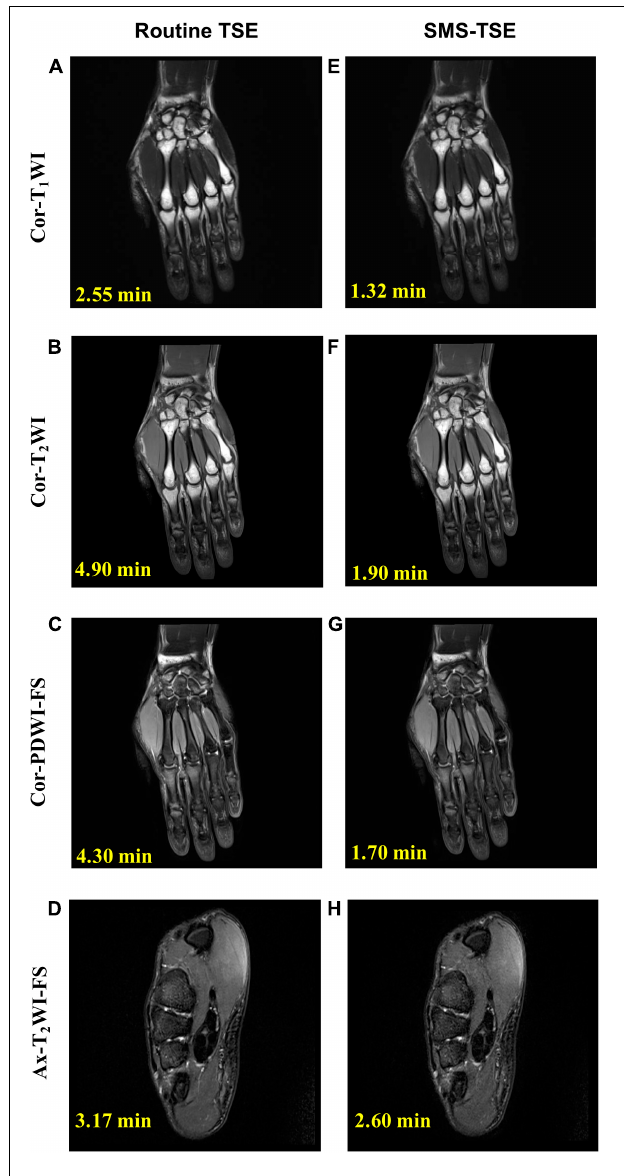
FIGURE 1 | Comparison of high-resolution turbo spin-echo (TSE) sequence and simultaneous multi-slice-TSE sequence in the wrist joint imaging. The median nerve is thickened and swollen and shows hyperintensity on axial-T2-weighted imaging-fat saturation imaging (arrow), and the final diagnosis is carpal tunnel syndrome. All the images scored 5 in the image quality evaluation. For routine TSE, the SNR for Cor-T1WI (A) , Cor-T2WI (B) , Cor-PDWI-FS (C) , and Ax-T2WI-FS (D) were 228.46, 108.76, 279.91, and 123.75; and the CNR for each was 192.21, 313.92, 72.77, and 71.55. For the SMS-TSE, the SNR for Cor-T1WI (E) , Cor-T2WI (F) , Cor-PDWI-FS (G) , and Ax-T2WI-FS (H) were 208.36, 103.21, 182.86.91, and 103.71; and the CNR for each was 203.31, 308.65, 58.76, and